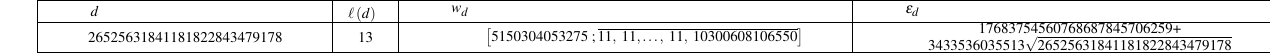
Table 2 Numerical Results for Corollary